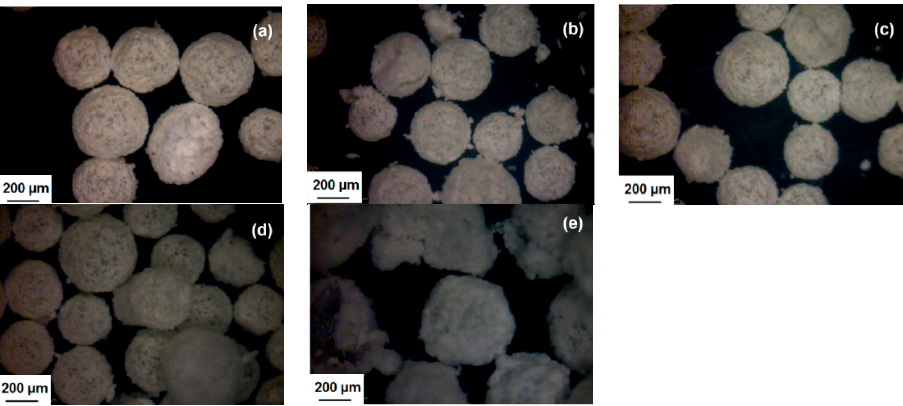
Figure 6. Digital microscopic images of microcapsules with increasing M/U ratio: ( a ) 0; ( b ) 0.03; ( c )